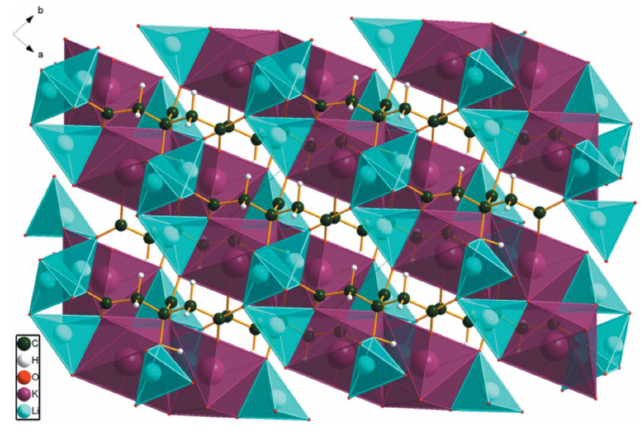
Figure 5 Crystal structure of Li 2 KC 6 H 5 O 7 , viewed down the c -axis direction.